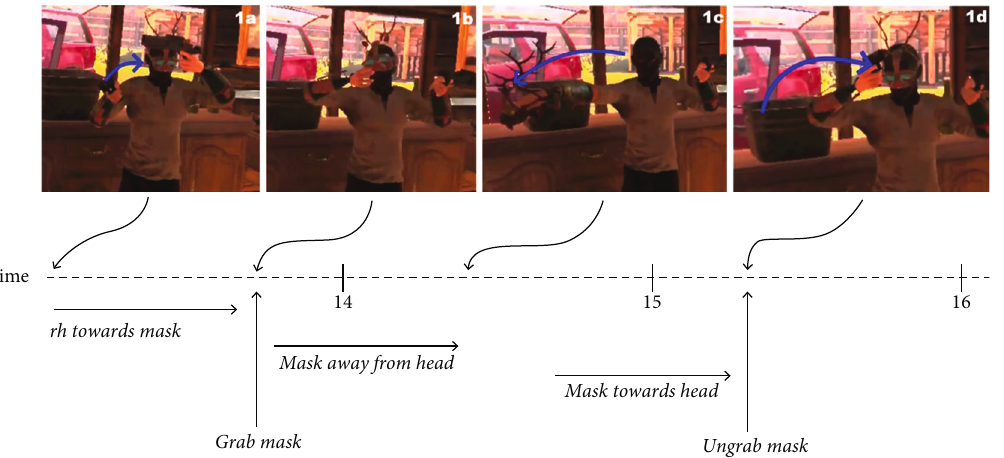
Figure 9: Removing and reequipping the mask. Neutral rendering.